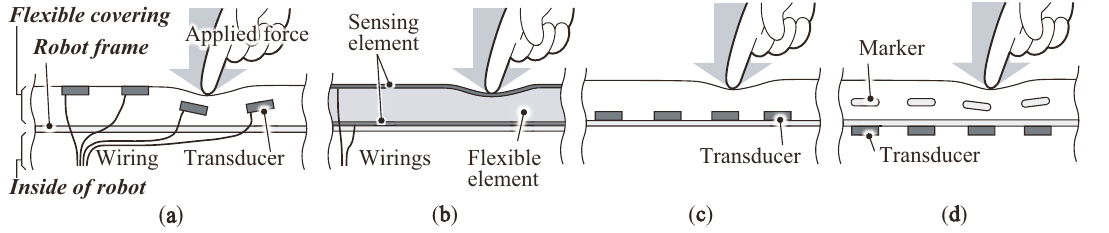
Figure 2. Schematics of the structures of conventional flexible tactile sensors holding a thick flexible contact layer: ( a ) type A; ( b ) type B; ( c ) type C; ( d ) type